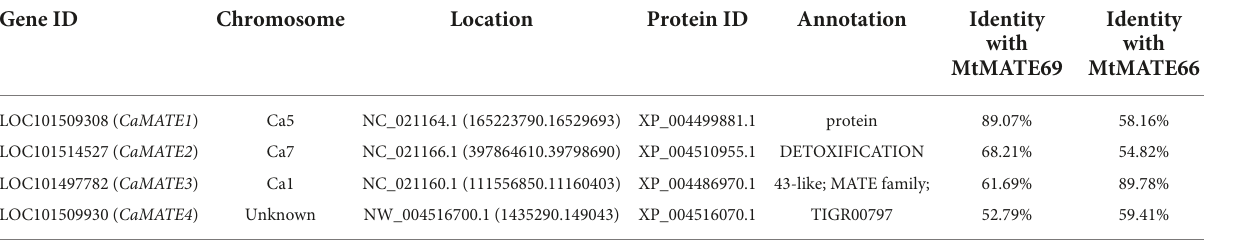
TABLE 2 List of homologous MATE genes identified in chickpea. Gene